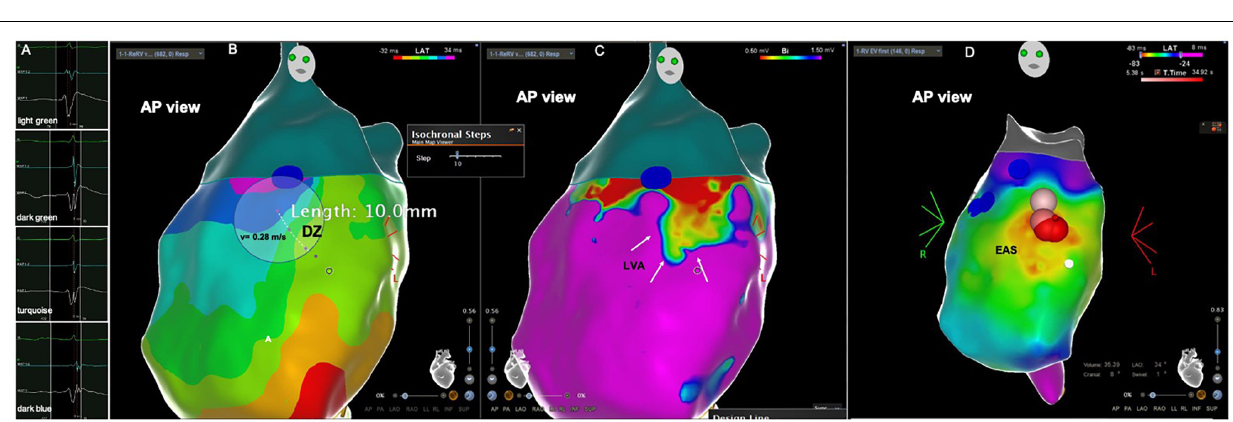
FIGURE 5 | Patient from the PVC group with DZ outside the LVAs. (A) Intracardiac electrograms corresponding to the respective isochrones presented in the isochronal map. (B) RVOT isochronal map in sinus rhythm with DZ in the RVOT free wall. (C) Voltage map in sinus rhythm with normal voltage at the DZ. DZ, deceleration zone; LVA, low voltage area; RVOT, right ventricular outflow tract.